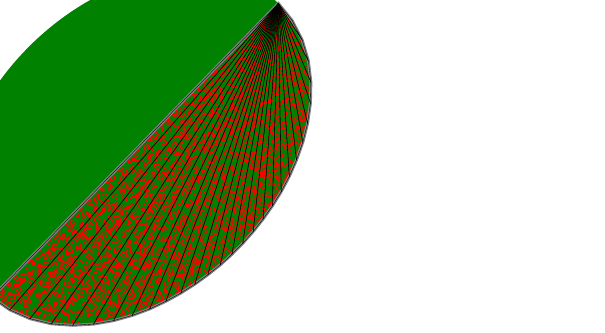
Figure 8. The sampling space result of half ellipse in head-on and crossing situation area.